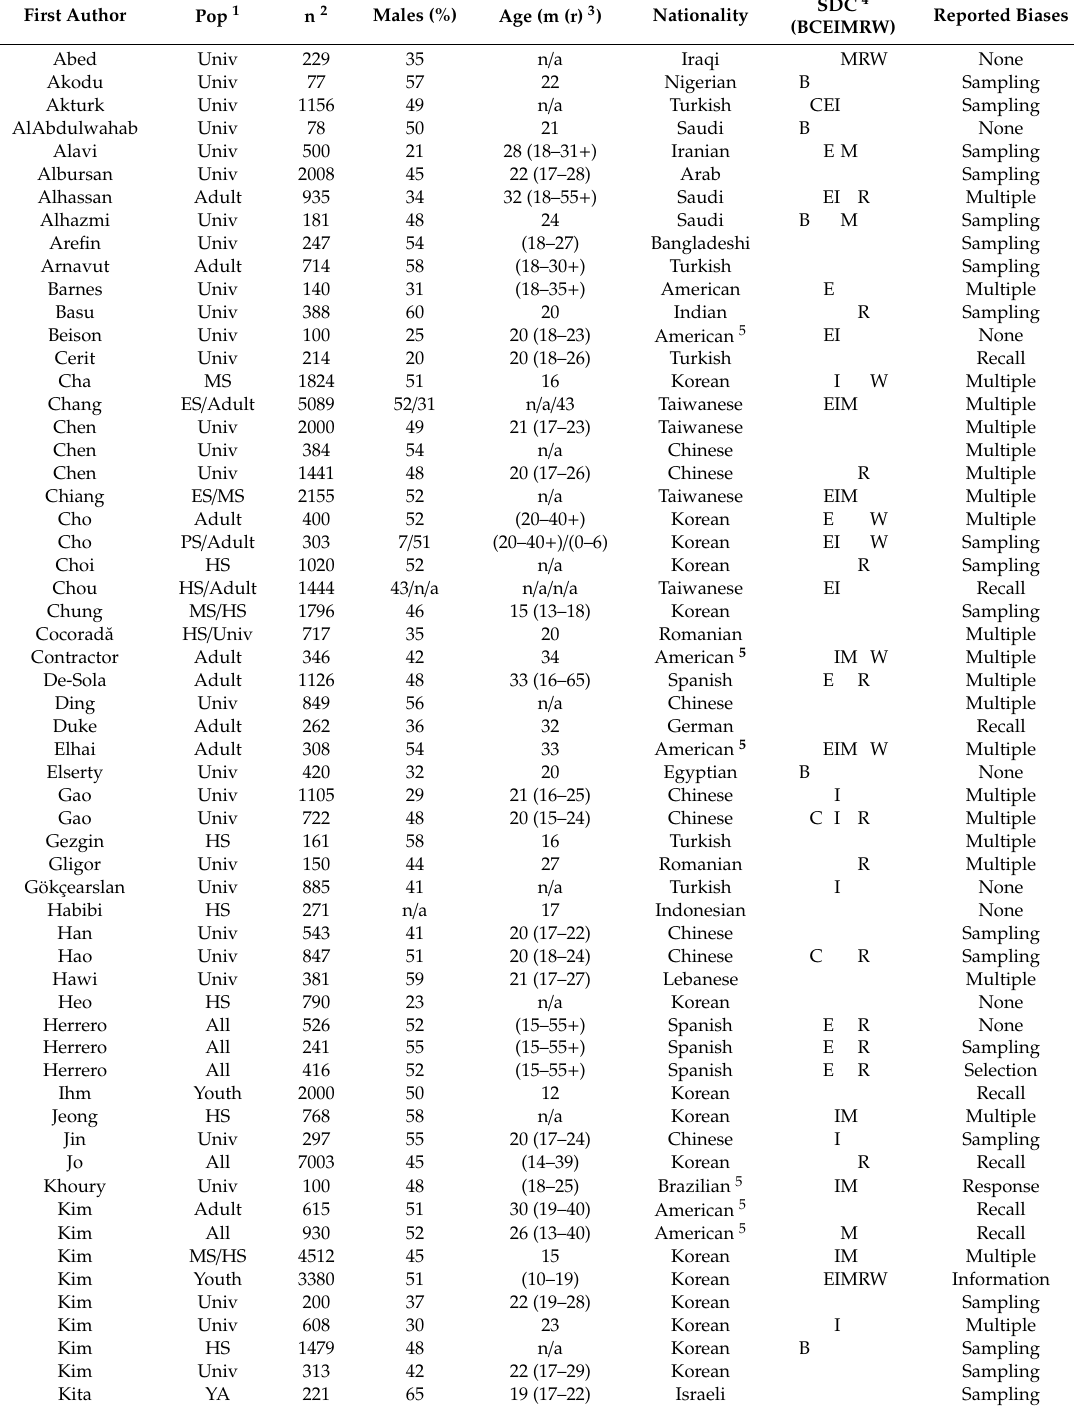
Table 4. Demographic profile of smartphone study samples and reported study